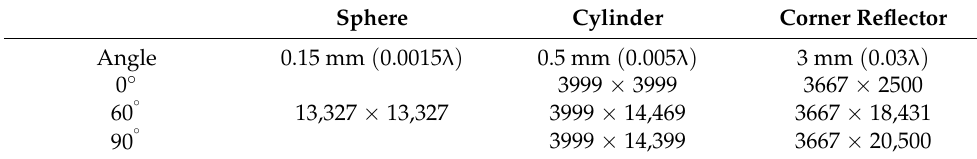
Table 3. The number of ray tubes at a specified incident direction in conventional SBR. Sphere Cylinder Corner Sphere